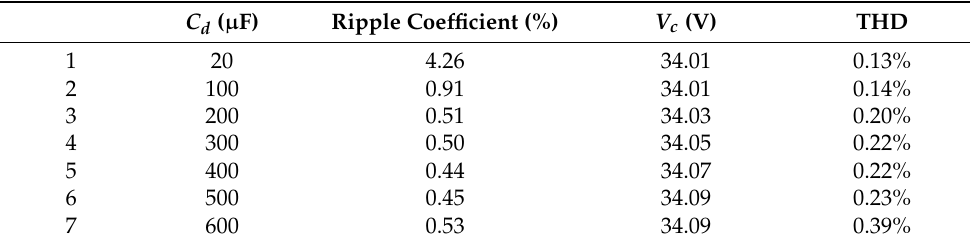
Table 4. Parameters under improved modulation